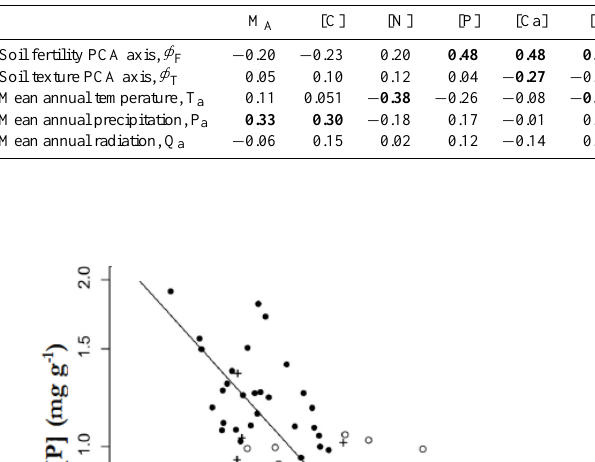
Table 5. Kendall’s partial correlation coefficient, τ P , for the environmental contribution (plot effect estimate) of each foliar property (con- trolling for the effects of the other environmental predictors) with their significance estimated as detailed in Maghsoodloo and Laszlo Pallos (1981). Bold values indicate a very strong correlation ( p < 0 . 001) and italics indicate significant correlations at p < 0 . 01; see text for details. M A = leaf mass per unit area; elemental concentrations are on a dry weight basis, L A = leaf area; ‘ A = leaflet area, 8 LS = leaf area/sapwood area ratio, ρ x = branch xylem density, (cid:11) = diffusion limitation index (see Eq. 1) and ů 1 and ů 2 are the first two principal components of the PCA analysis on the environmental effects correlation matrix (See Table 4).